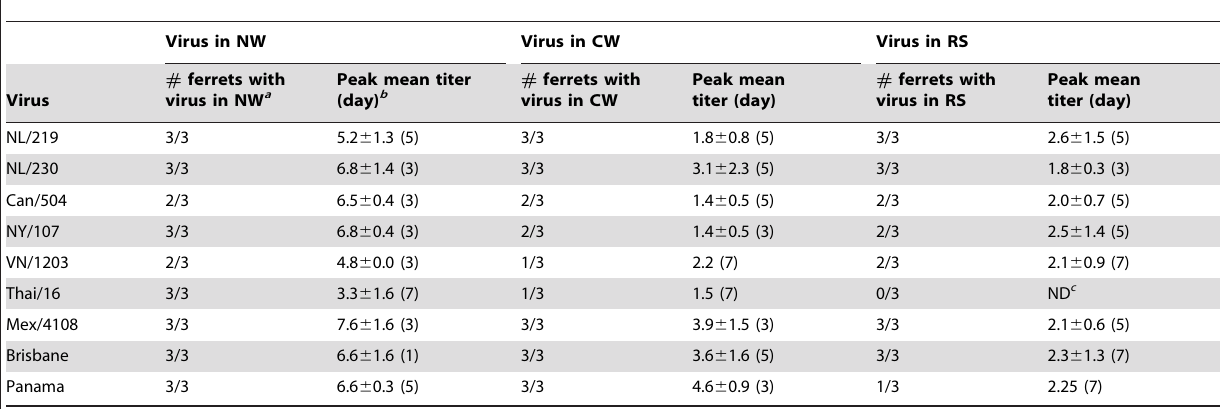
Table 2. Incidence of viral replication in ferrets following 10 6 EID 50 ocular inoculation.